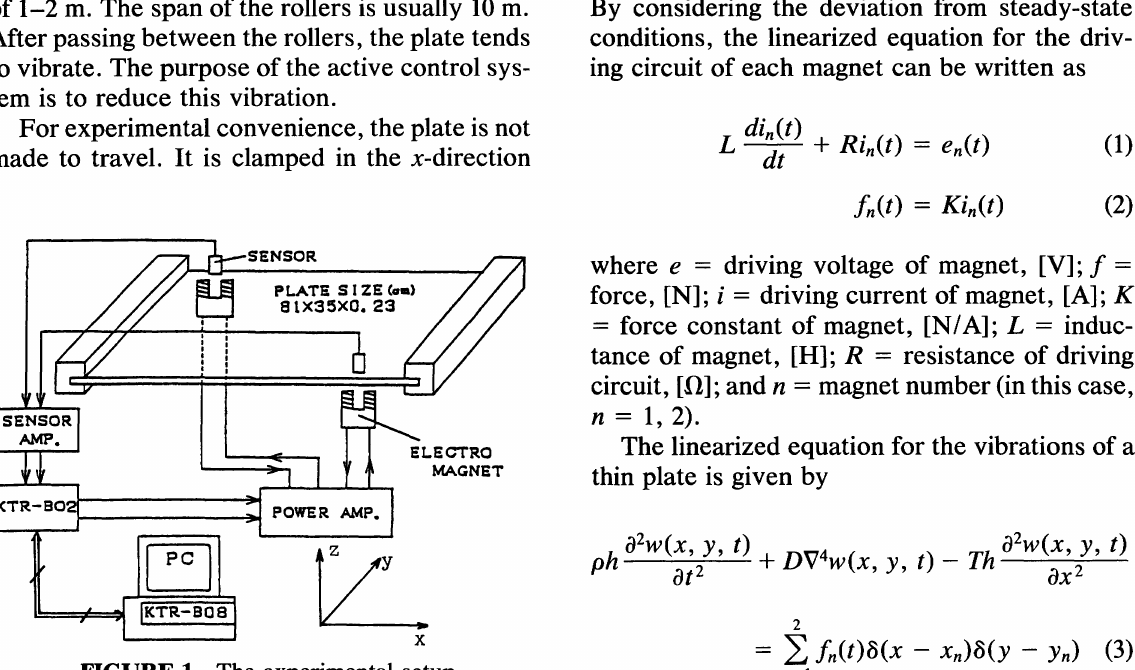
FIGURE 1 The experimental setup.